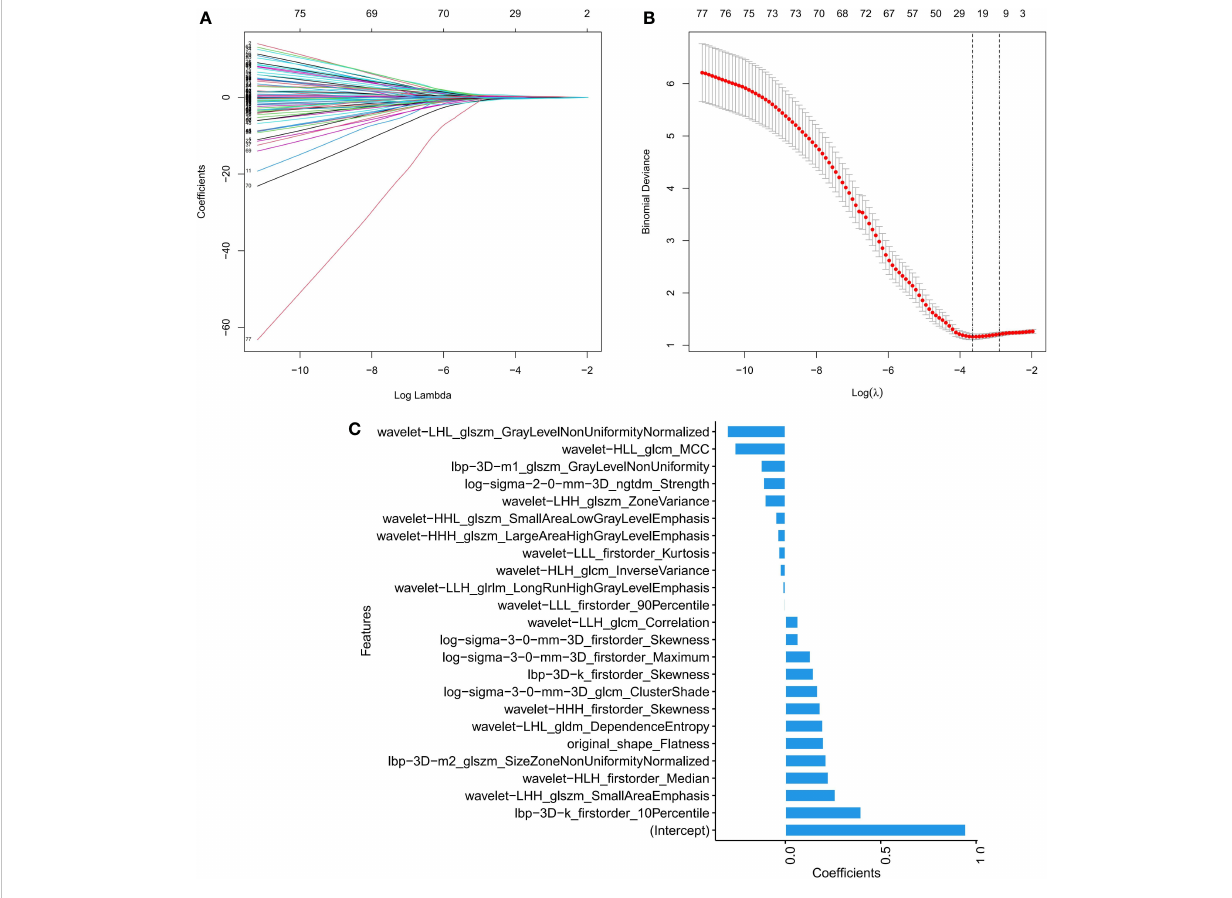
FIGURE 2 Feature selection by LASSO binary logistic regression model. (A) Selecting characterization via LASSO regression and 10-fold cross-validation method. (B) Coef fi cient curves based on radiomics features with non-zero coef fi cients are determined by l . (C) Screening the absolute values of 23 radiomics features and their corresponding coef fi